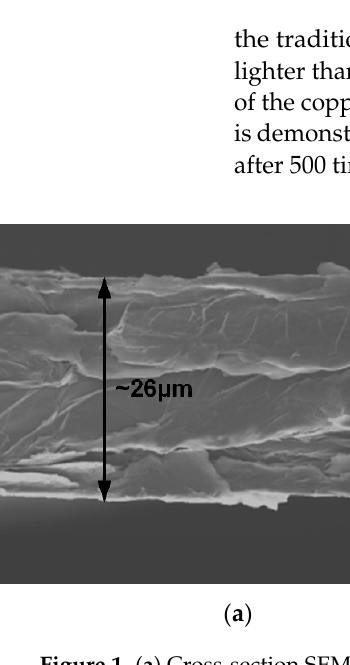
Figure 1. ( a ) Cross-section SEM image of the FGF. ( b ) Experiment of the mechanical reliability of the FGF.